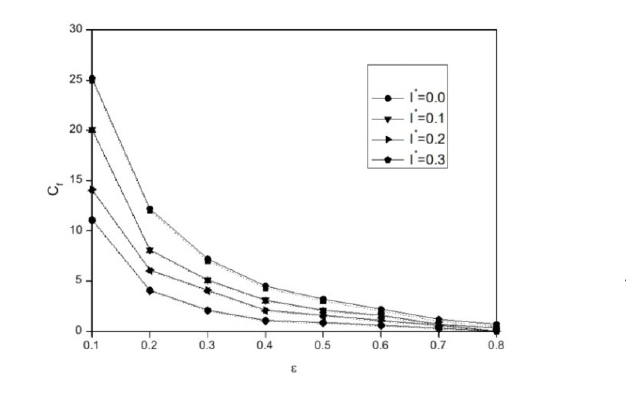
Fig. 7: Friction coeflcient versus eccentricity ratio for different val- ues of the couple stress parameter with roughness parameter 0.1